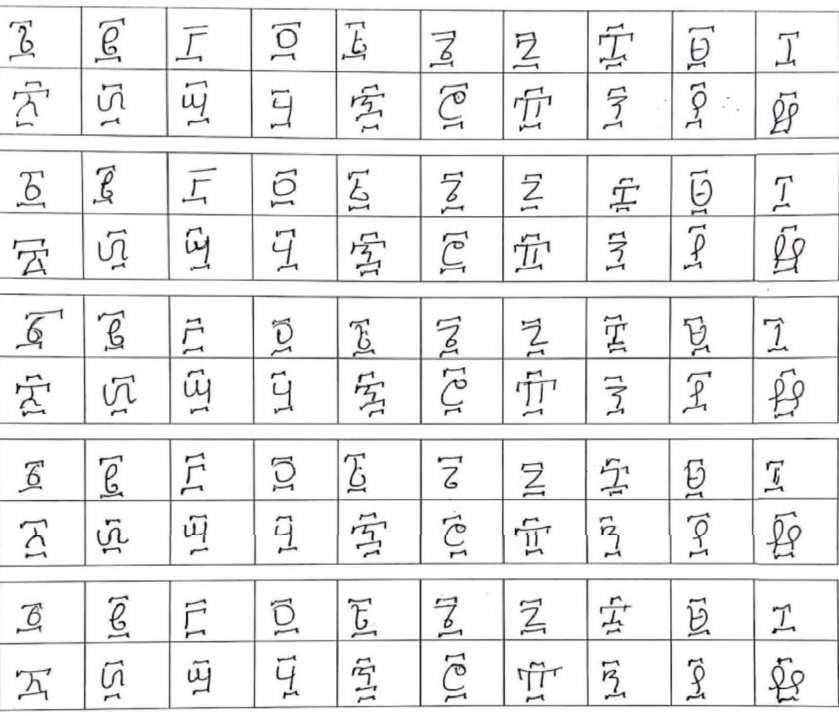
Figure 2: Sample handwritten Geez digit